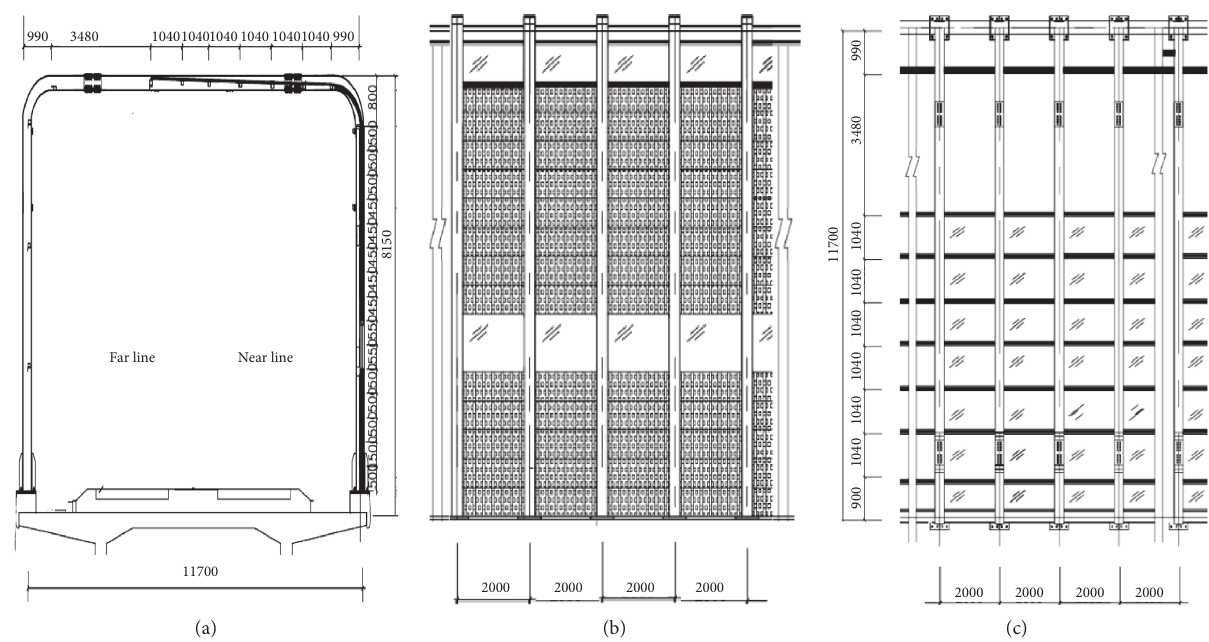
Figure 2: Dimensions of target semienclosed noise barrier: (a) cross section; (b) elevations; (c) top view (unit: